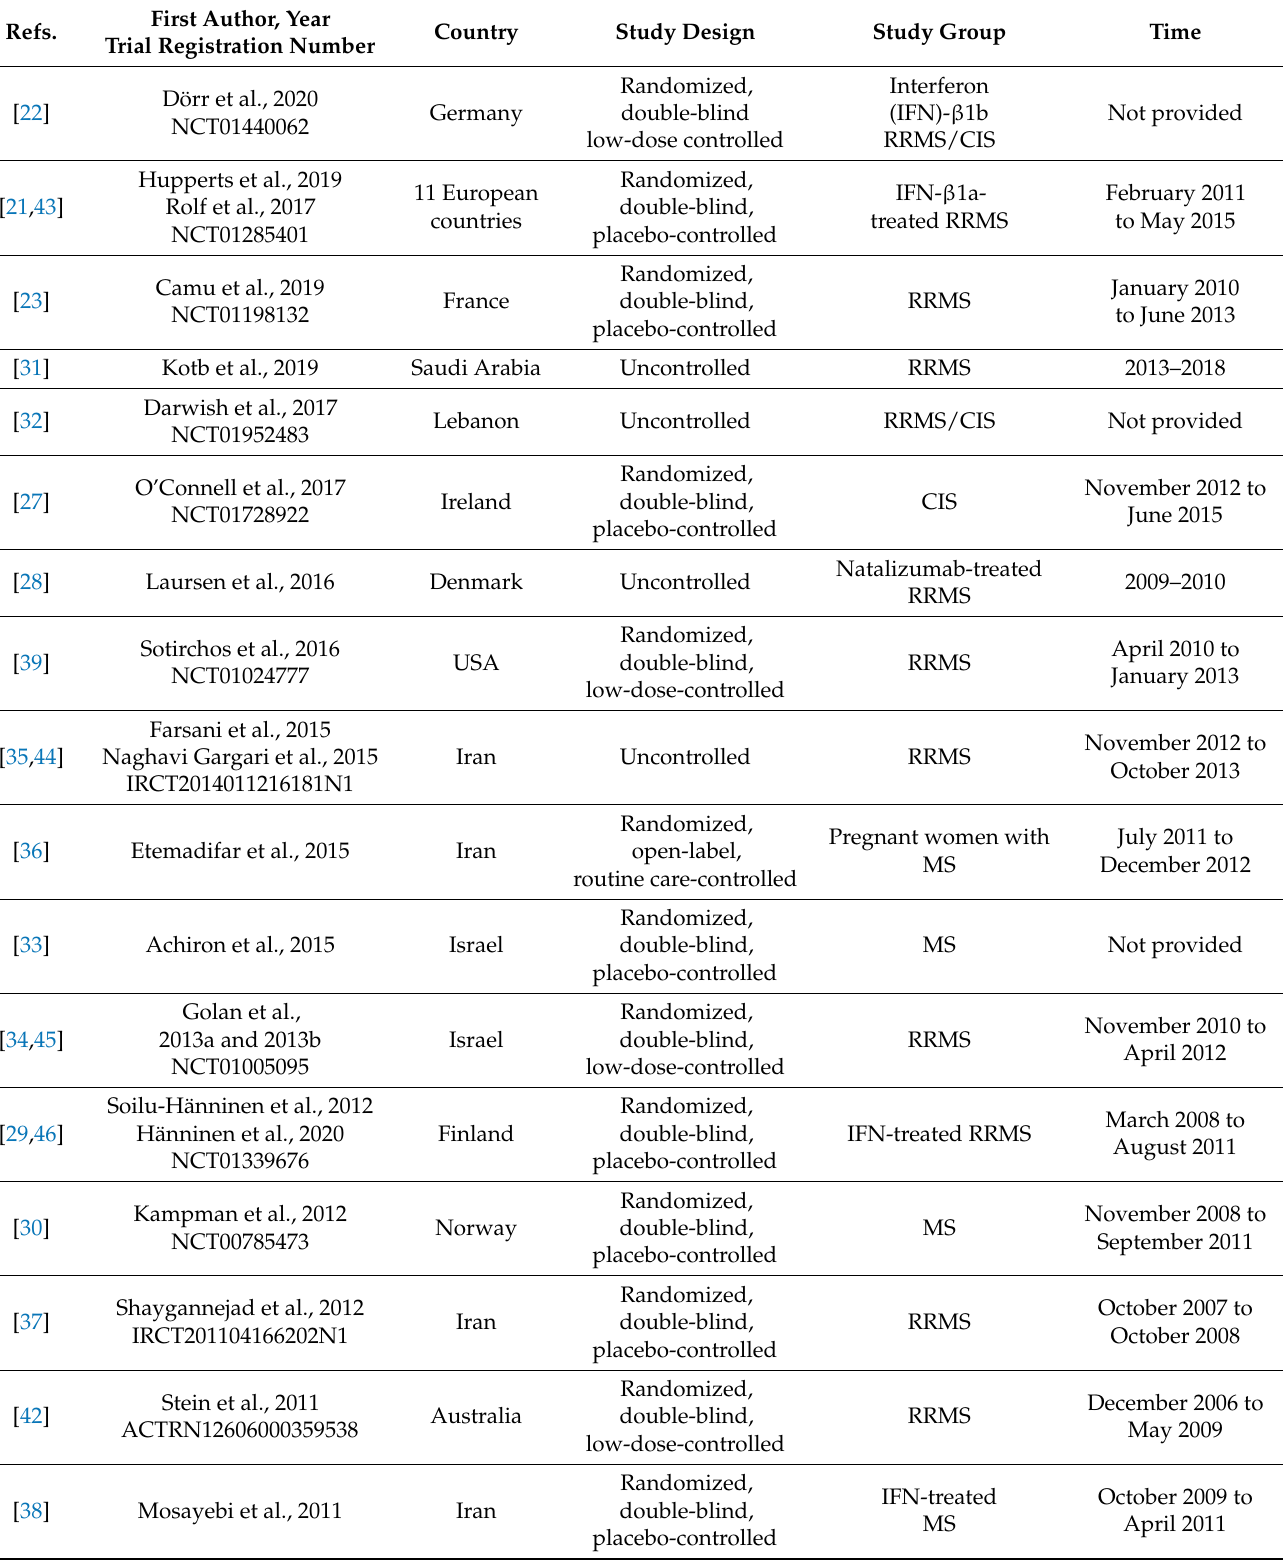
Table 2. Characteristics of selected studies. Sub-studies are grouped with the main study.